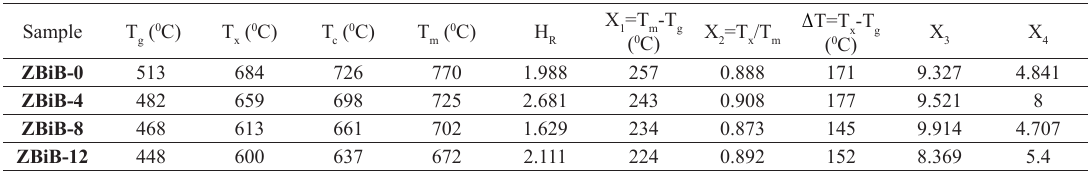
Table 2. Characteristic temperatures and thermal stability parameters of the selected glasses obtained using DTA curves. Sample